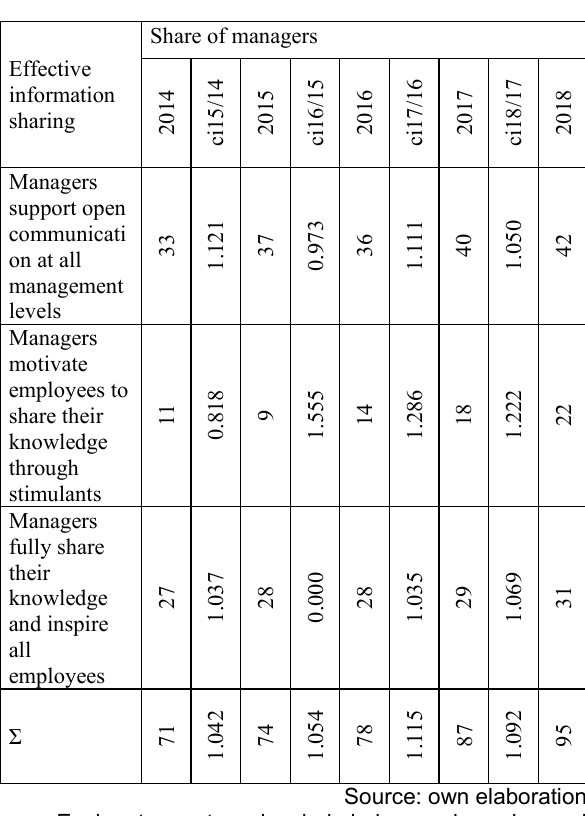
Table 4. Chain Index of Changes -